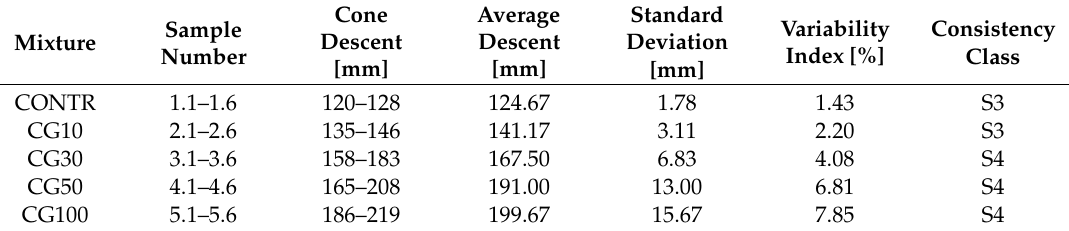
Table 7. Results of testing the consistency of concrete